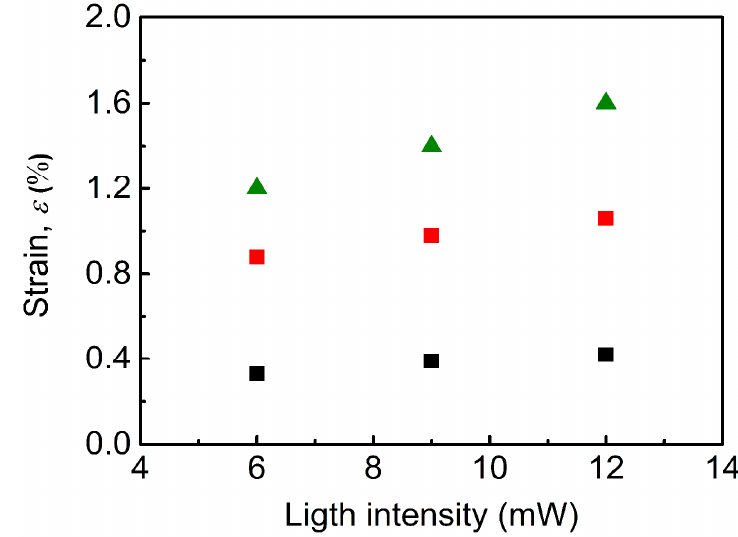
Figure 9. Photo-actuation strain as a function of the light intensity.